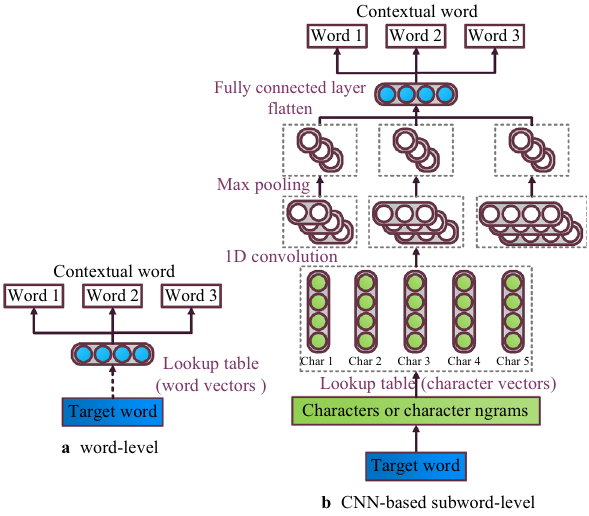
Fig. 19 Illustration of word-level and CNN-based subword-level word embedding models